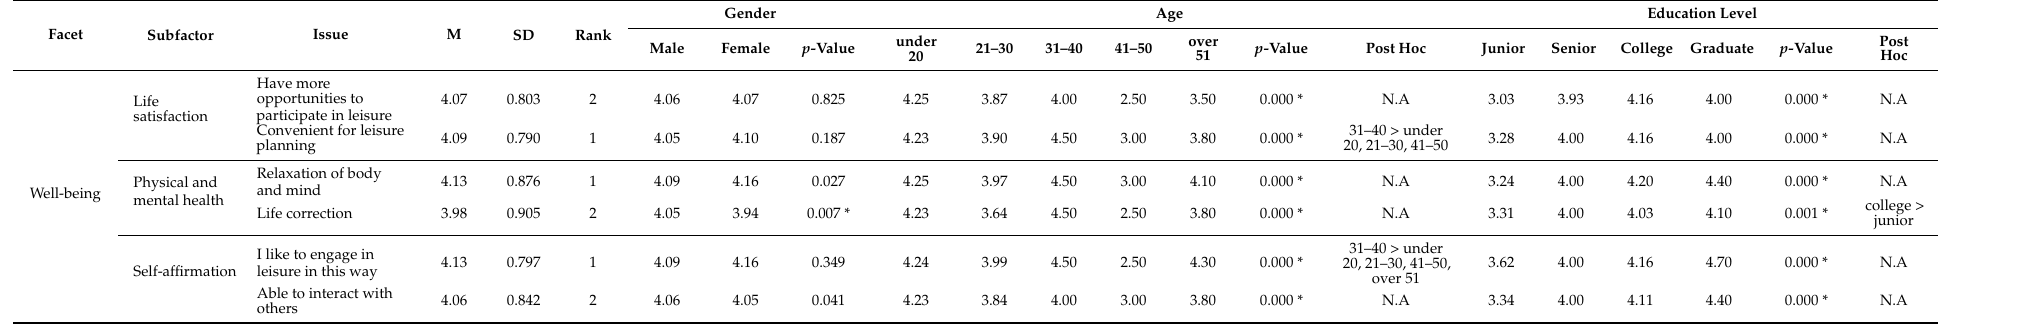
Table 3. Analysis of cognitive differences in